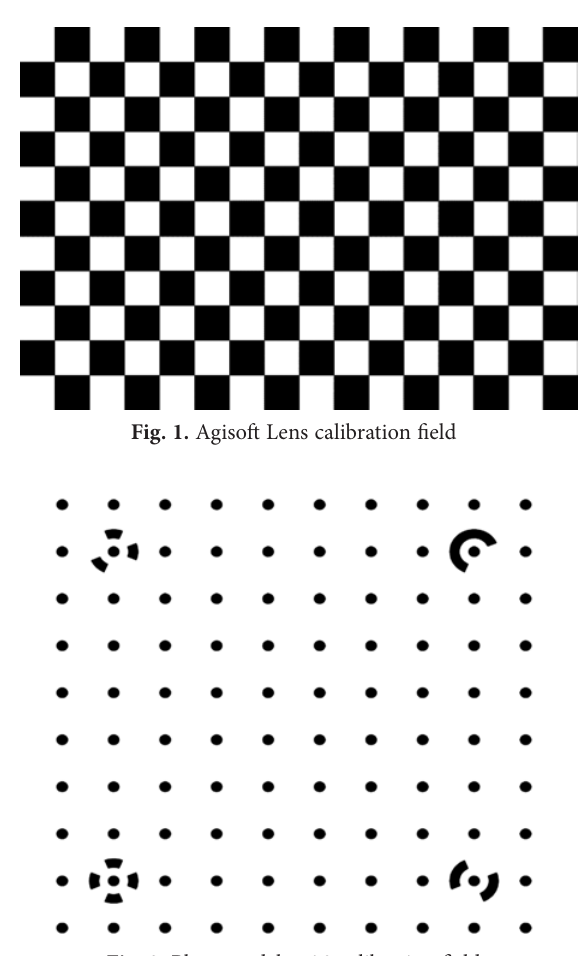
Fig. 2. Photomodeler 6.2 calibration